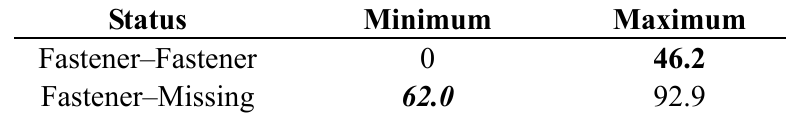
Table 3. Intra and interclass distances using Equation (2) with weight